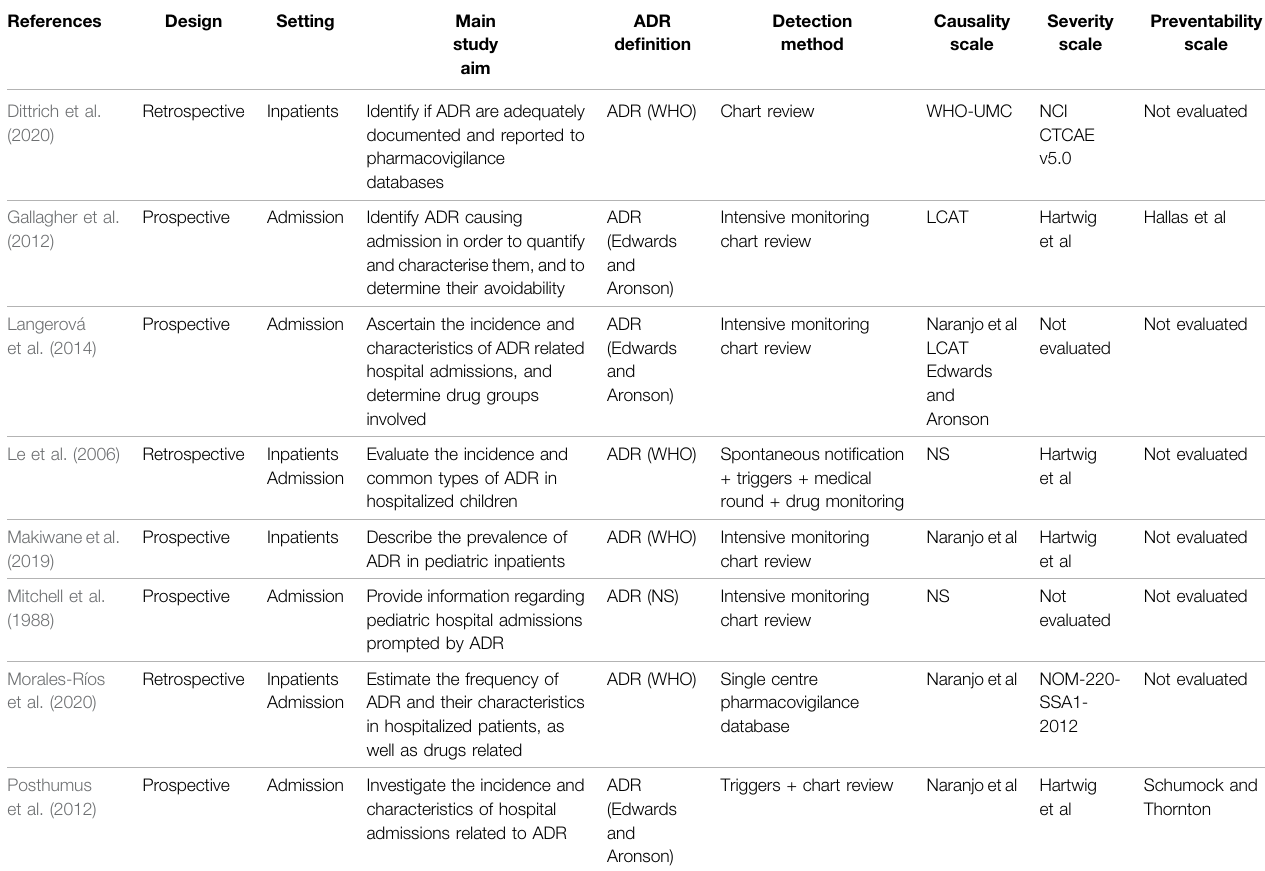
TABLE 2 | Methodology characteristics in pediatric studies with oncohematology